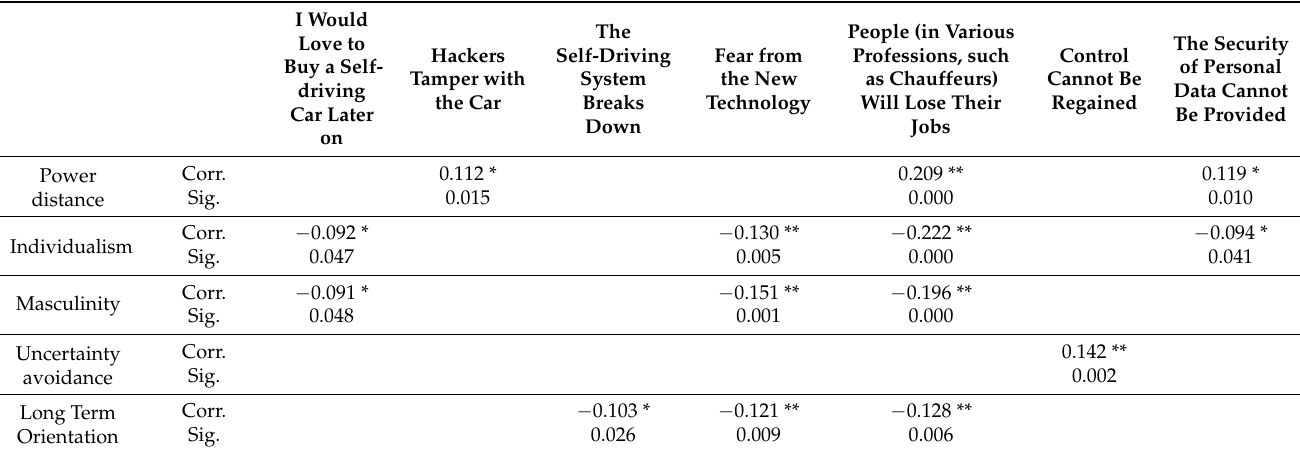
Table 4. The significant relations of cultural dimensions and perceptions within the international sample.